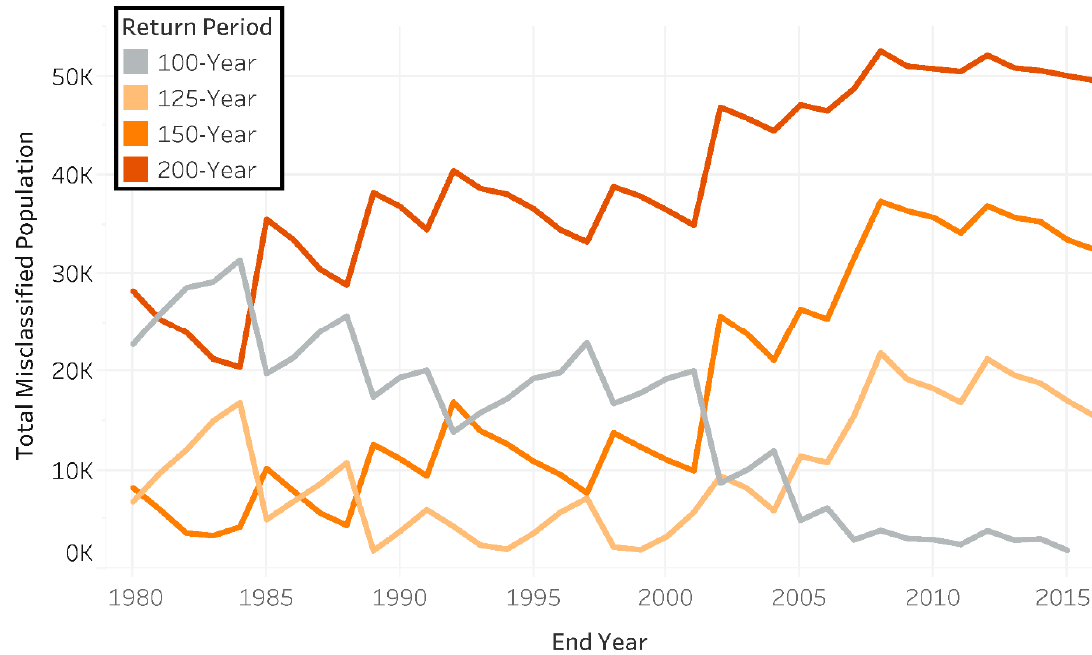
Figure 8. Total misclassified population over time by return period relative to the 2016 baseline.